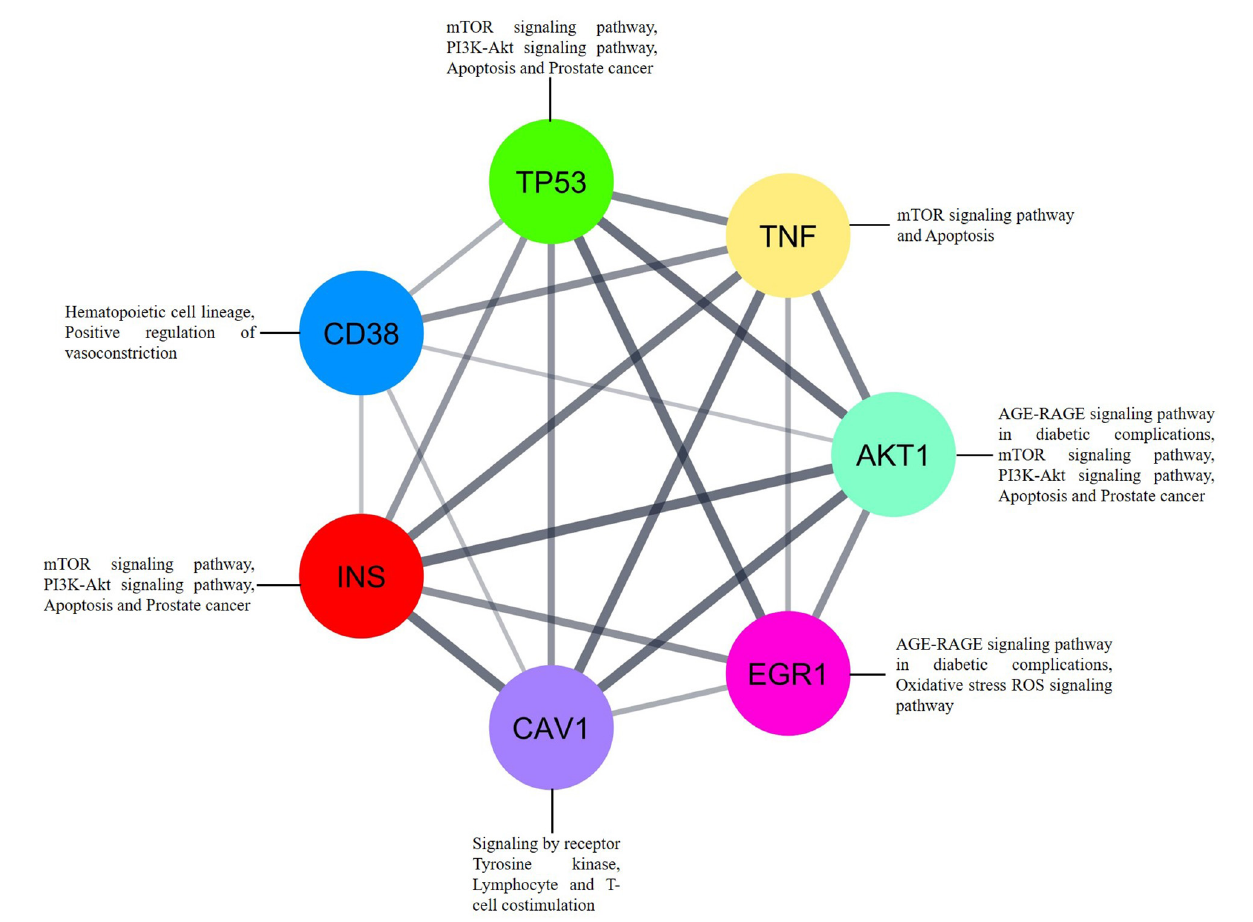
FIGURE 7 | The interrelation analysis of genes EGR1 , CD38 , CAV1 , and AKT1 that strongly associated to SLE. Each gene involved in different pathways via interacting to each other. Inbuilt color code was provided to all the genes based on the STRING tool from Cytoscape.